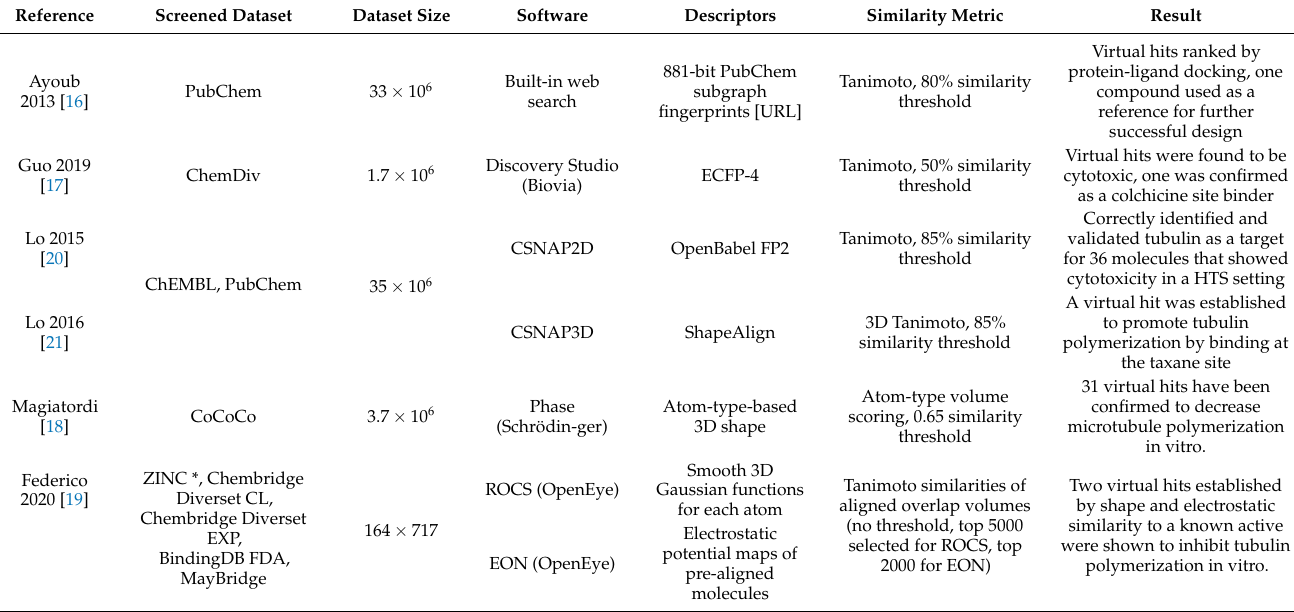
Table A1. Summary of similarity search